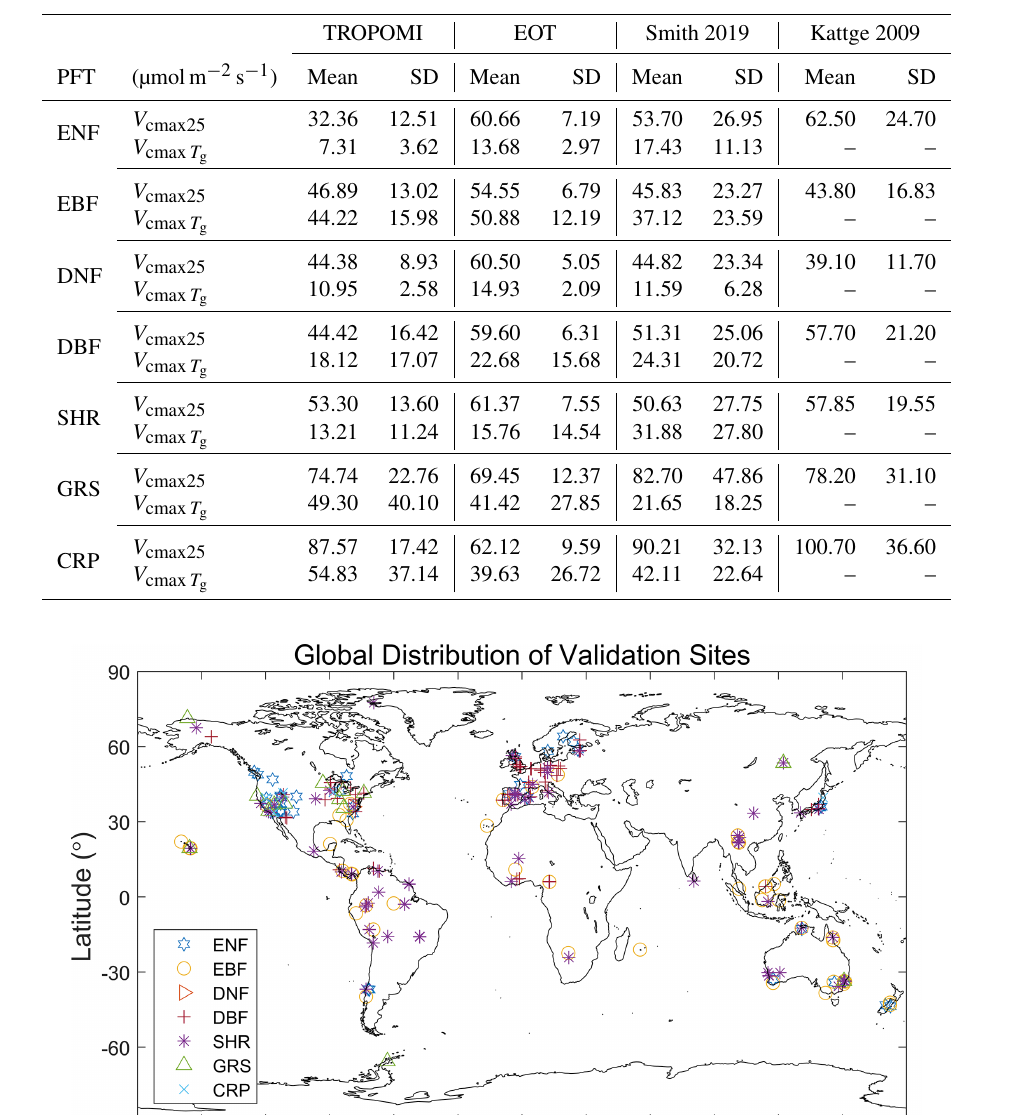
) and normalized to 25 ◦ C ( V cmax25 ) for different g